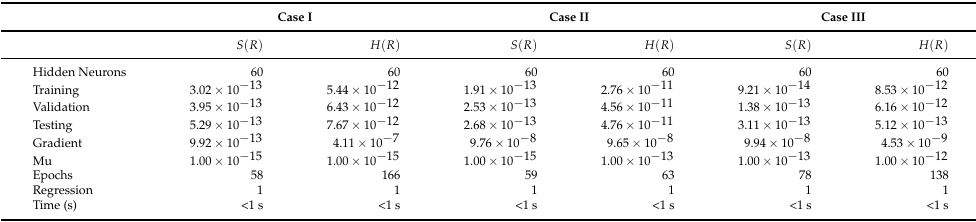
Figure 6. Performance of NNs–LM technique in terms of mean square error for ( a , c , e ) dimensionless concentration of substrate and ( b , d , f ) hydrogen peroxide of scenario II. Table 2. Statistical analysis of performance measures including MSE, Gradient, mu, number of iterations and time taken by the system for obtaining the results of Scenario